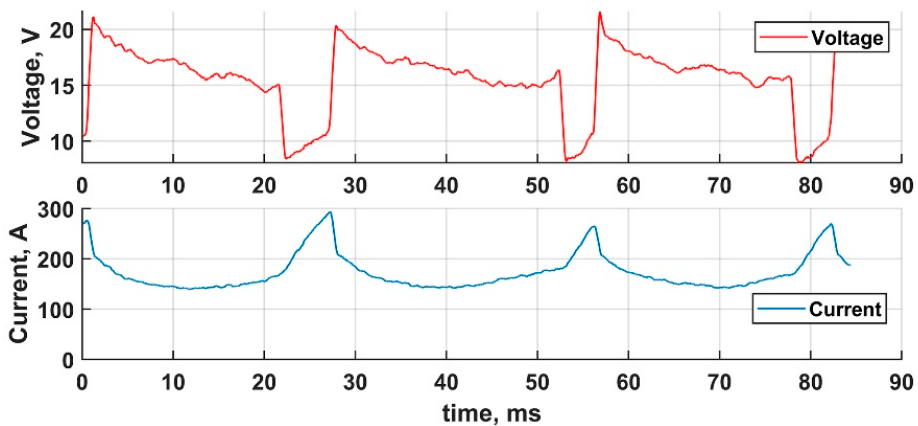
Figure 8. Three definitive DCEN cycles.